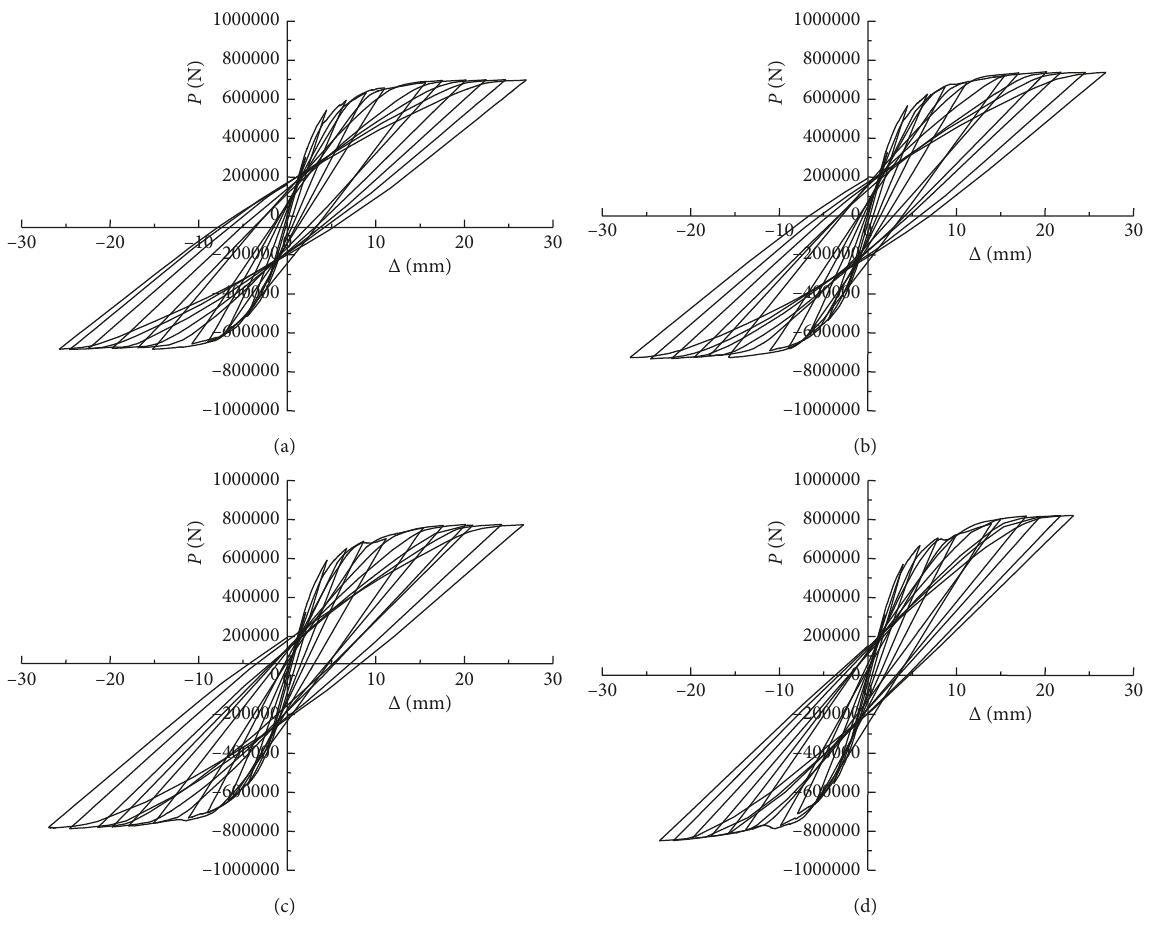
Figure 11: Hysteresis curves of frames with various reinforcement ratios. (a) K-5. (b) K-6. (c) K-1. (d)